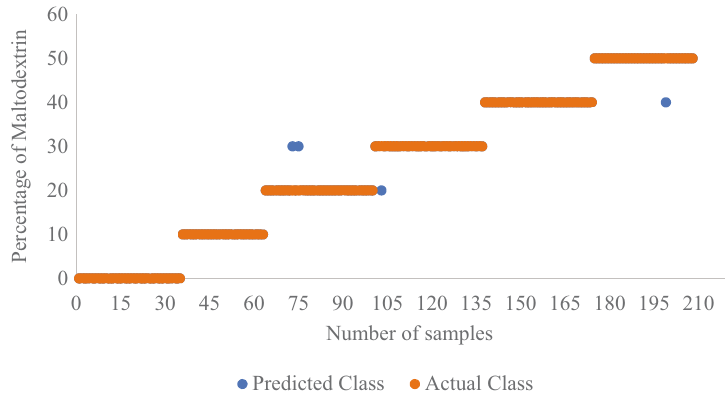
Figure 7: Scatter plot diagram of maltodextrin added in butter fl y - pea extract powder using SNV